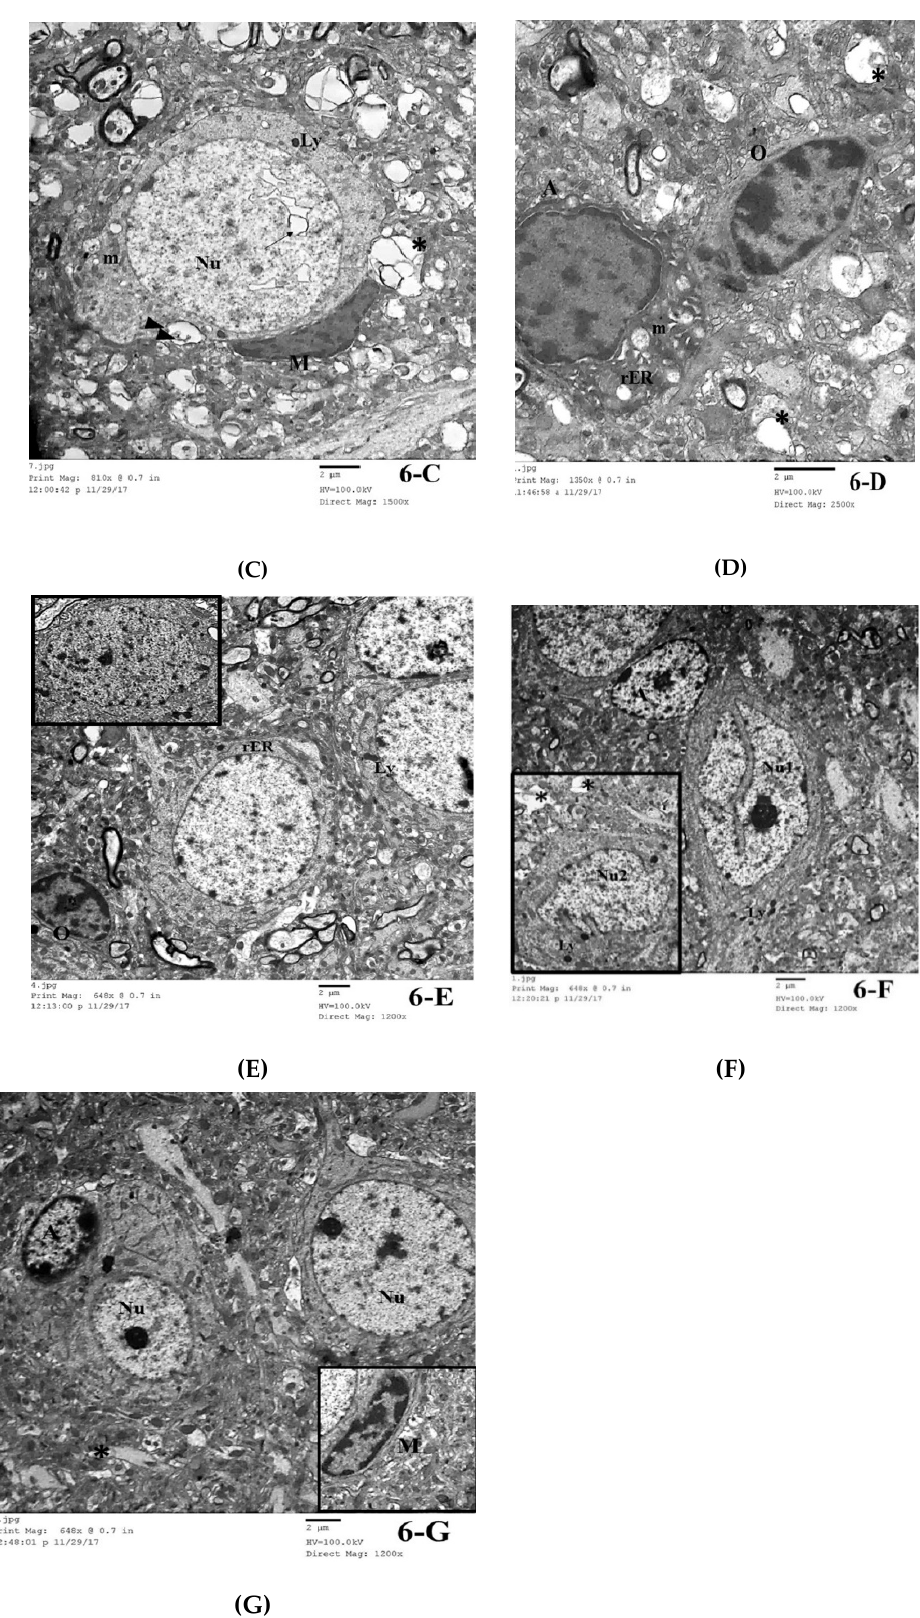
Figure 6. Electron microscopic examination (TEM) of frontal cortex in brain tissue for ( A ) Group I, showing a pyramidal cell in cerebral cortex of Group I. A large, rounded, central and euchromatic nucleus (Nu) is seen surrounded by cytoplasm. Notice the rough endoplasmic reticulum (rER) and